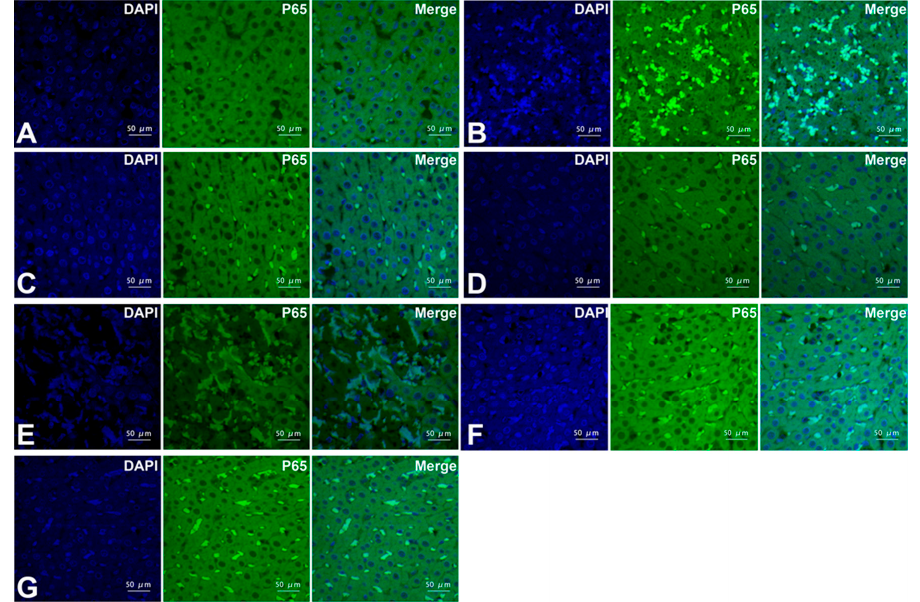
Figure 5. Expression of the phospho-NF- κ B subunit p65 protein in liver tissue of the different groups as measured by immunofluorescence staining observed via laser scanning confocal microscopy (LSCM) (magnification, ×400, scale bars, 50 μ m). ( A ) Group S; ( B ) group M; ( C ) group D1; ( D ) group D2; ( E ) group B1; ( F ) group B2; and ( G ) group B3. Positive p65 cells were stained green, and the sections were counterstained with 4,6-diamidino-2-phenylindole(DAPI) to visualize the nuclei.